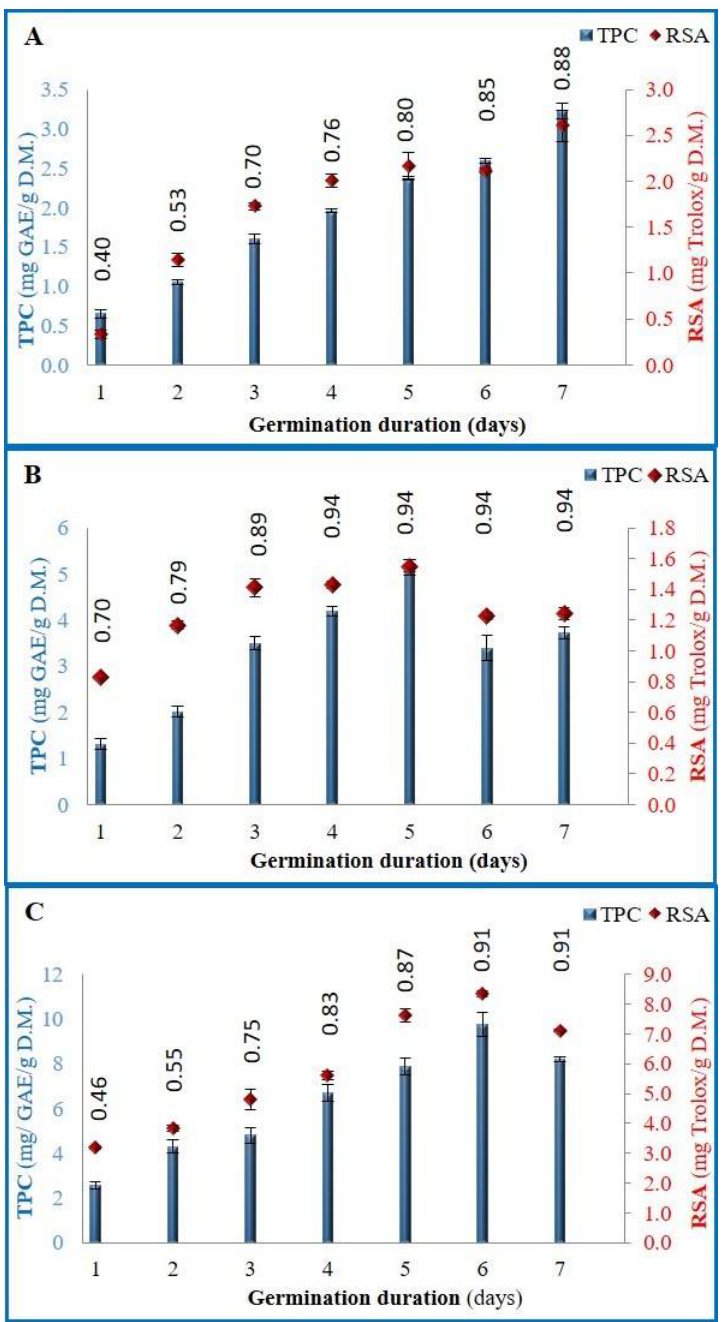
Figure 2. Total phenolic compounds (TPC) and radical scavenging activity against DPPH (RSA) of wheat ( A ), alfalfa ( B ), and radish ( C ) sprouts. Numbers on the graph represent the water content average of the sprouts at the corresponding day.